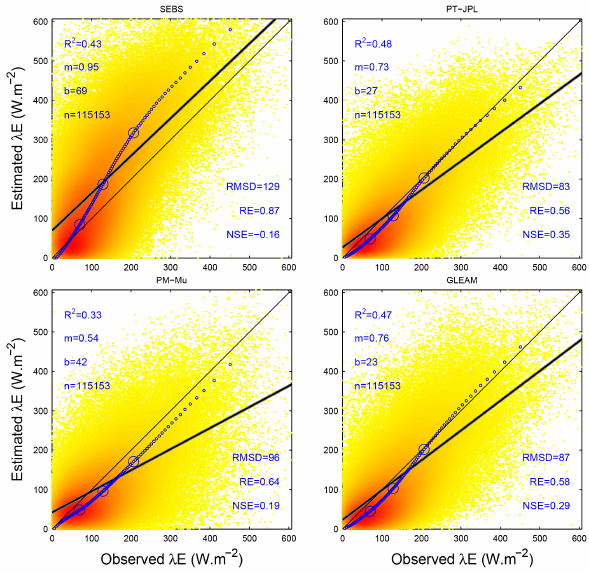
Figure 2. Scatter plots of observed vs. simulated latent heat flux for tower-based data. Colors show the frequency of values from high (red) to low (yellow). The thick black line represents the linear re- gression, while the thin line is the 1:1 line. The series of small circles show the percentile increments of data from the 1st to 99th, with large circles denoting the 25th, 50th and 75th percentiles. The statistics shown on each figure provide coefficient of determination ( R 2 ), slope ( m ), y intercept ( b ), number of data records ( n ), the root-mean-squared difference (RMSD), relative error (RE) and the Nash–Sutcliffe efficiency (NSE).